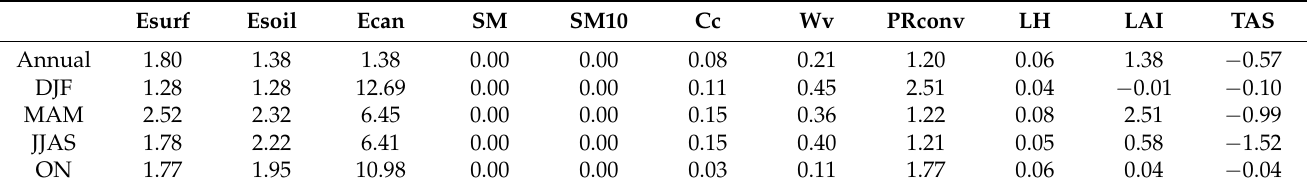
Table 3. Same as Table 1 but the values are for the correlation with PR changes.